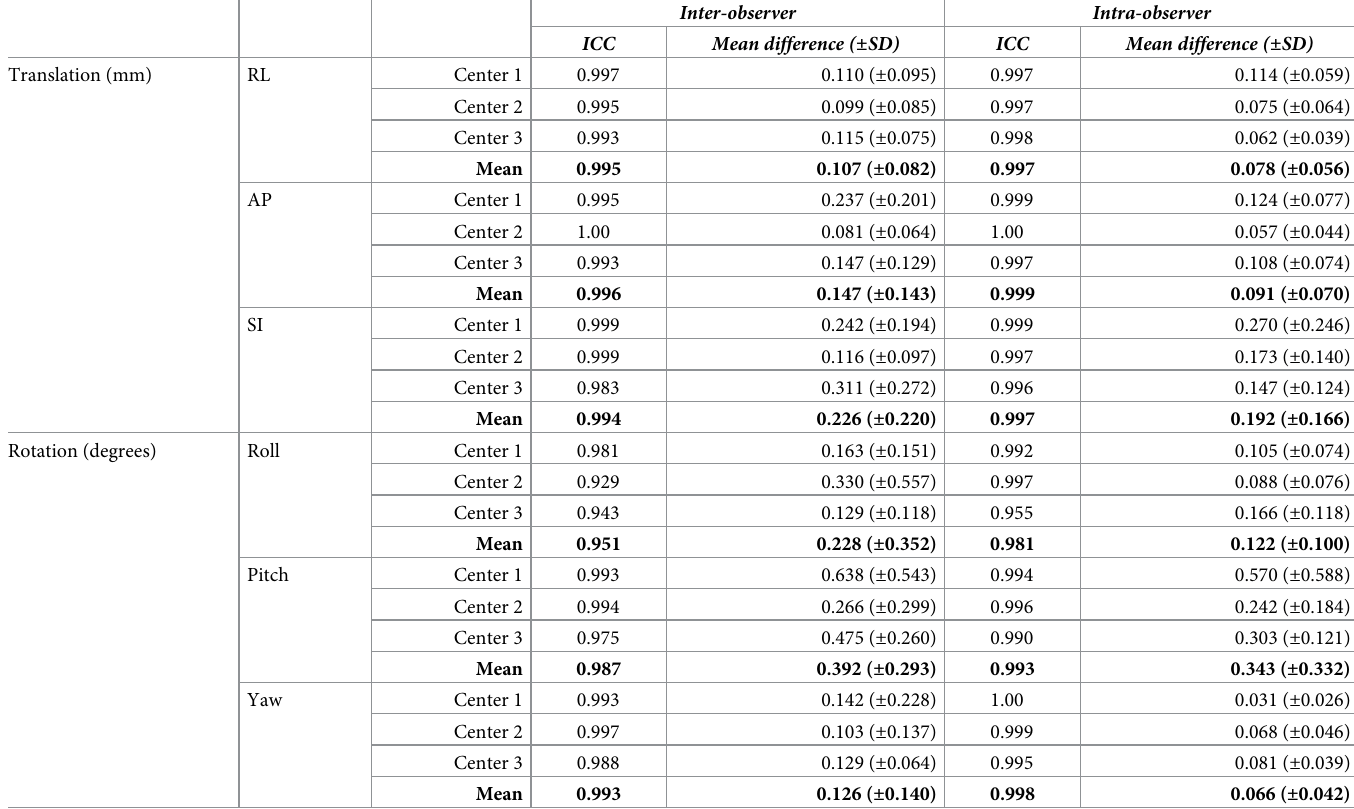
Table 4. Intra-observer and inter-observer differences and intraclass correlation coefficients (ICC) for measurements of the mandible.